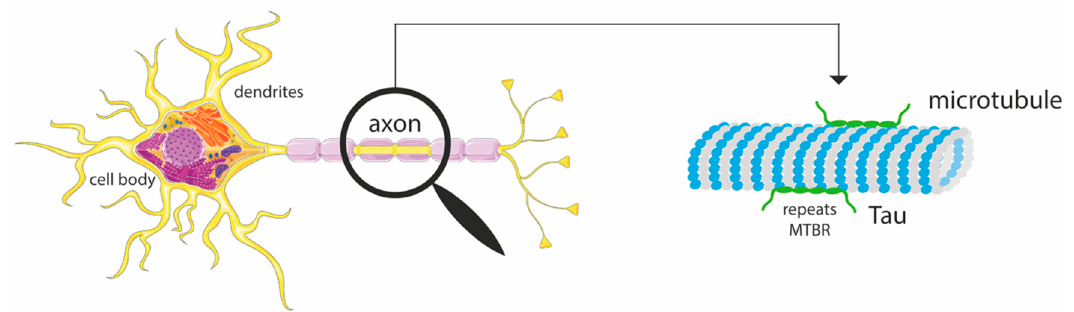
Figure 1. Graphical representation of a neuron, highlighting a microtubule present in the axon and the interaction with the tau protein, through the four repeats at the microtubule binding region (MTBR). Adapted from Servier Medical Art [5].